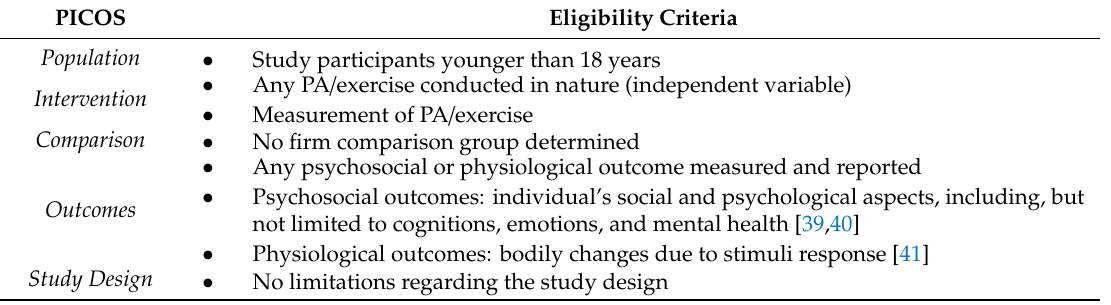
Table 1. Study selection